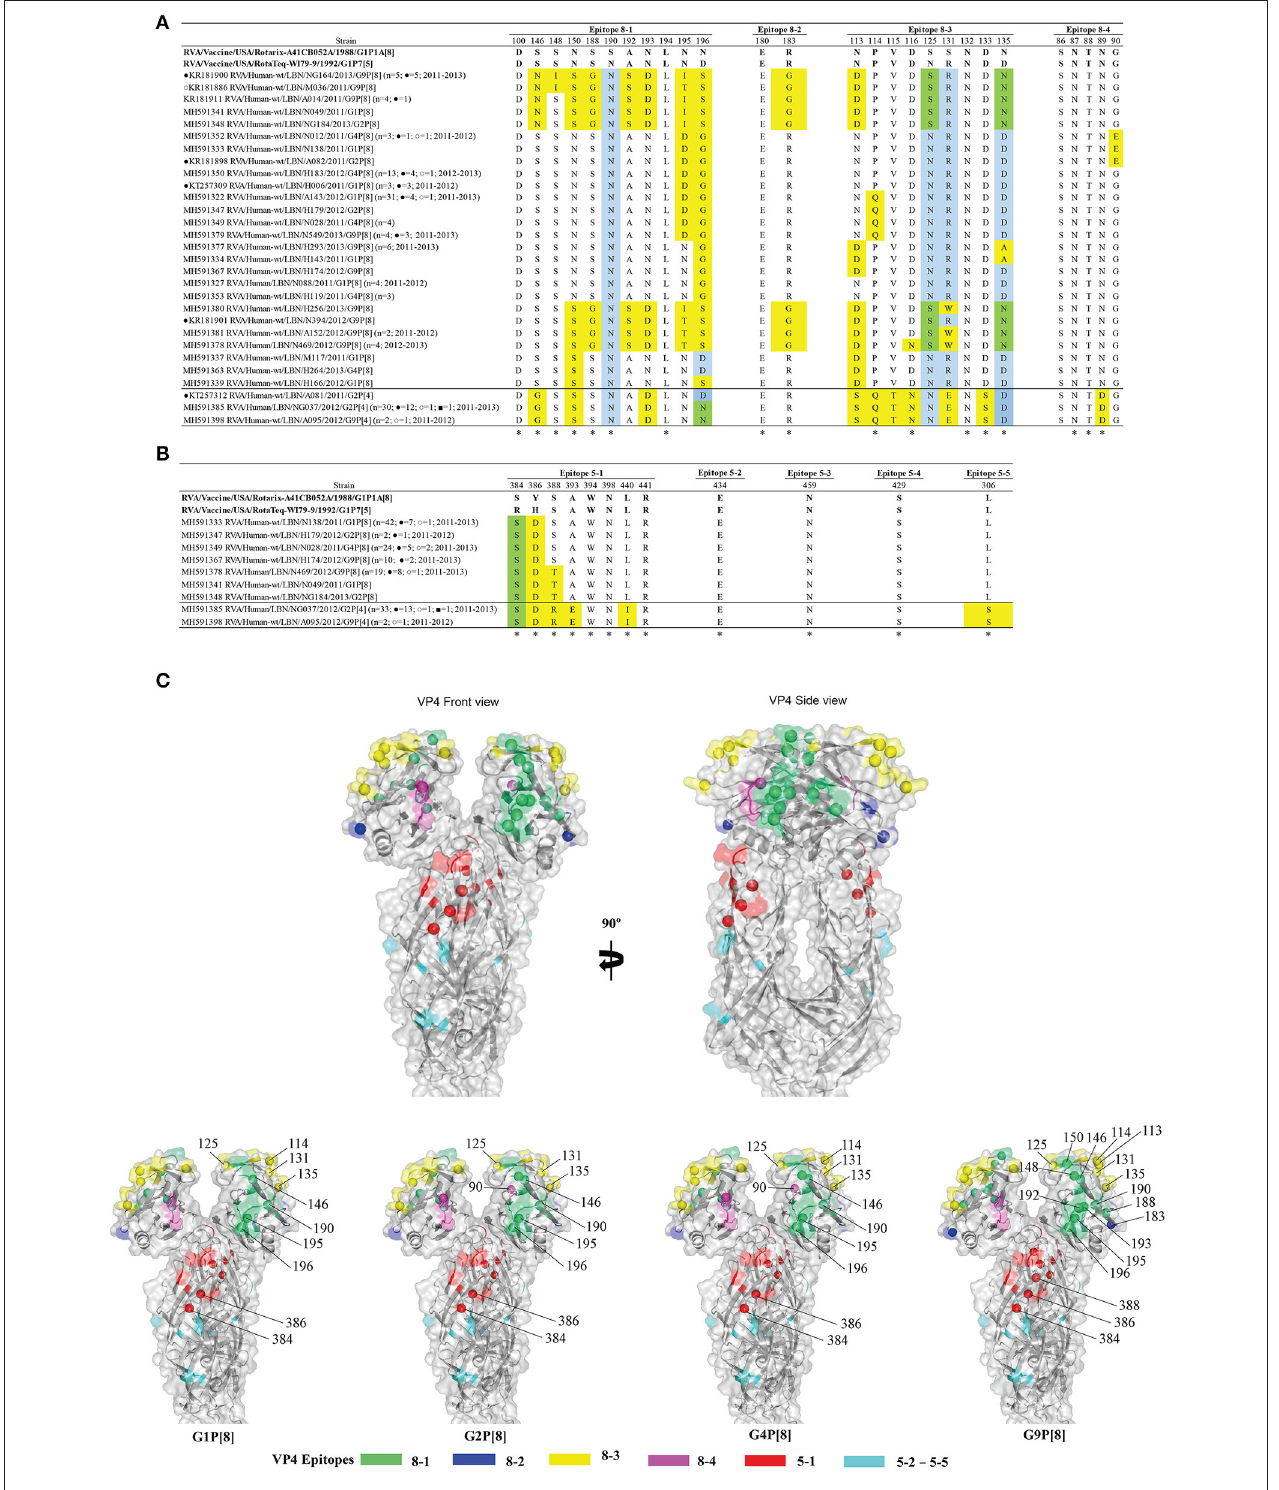
FIGURE 4 | Alignment of the antigenic epitopes of VP4 of the Lebanese RVAs with those of Rotarix ® and RotaTeq ® . Representative Lebanese strains corresponding to those in the VP4 tree are shown. (A) Alignment of the antigenic epitopes of the VP8 of the vaccines and representative RVAs circulating in Lebanon. (B) Alignment of the antigenic epitopes of the VP5 of the vaccines and representative RVAs circulating in Lebanon. Residues that are marked by yellow-color are residues that are different from Rotarix ® and RotaTeq ® , in green-color are residues that are different from the respective genotypic strain in RotaTeq ® , and blue-color are the